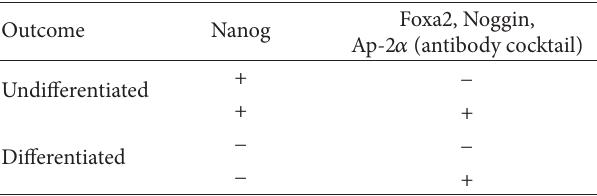
Table 2: Undifferentiated versus differentiated.